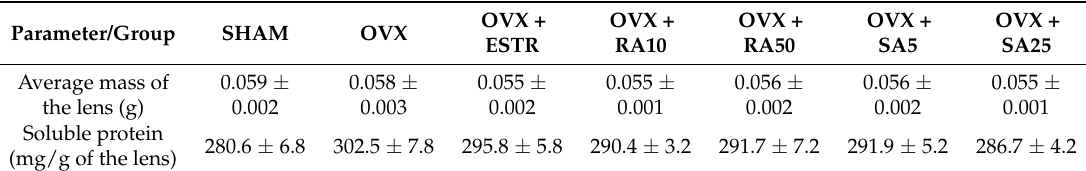
Table 1. Effects of rosmarinic acid and sinapic acid on the average lens mass and lens soluble protein content in ovariectomized